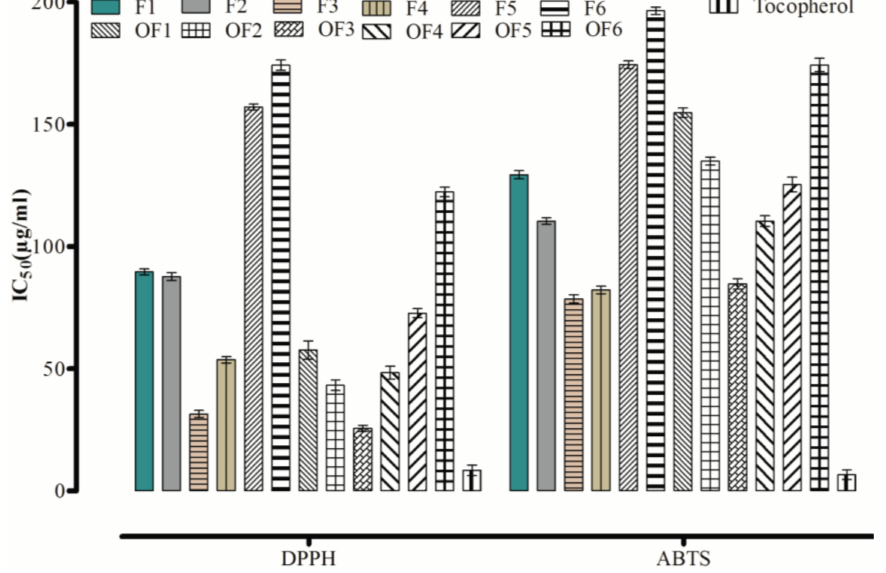
Figure 1. Antioxidant effects of flavones and